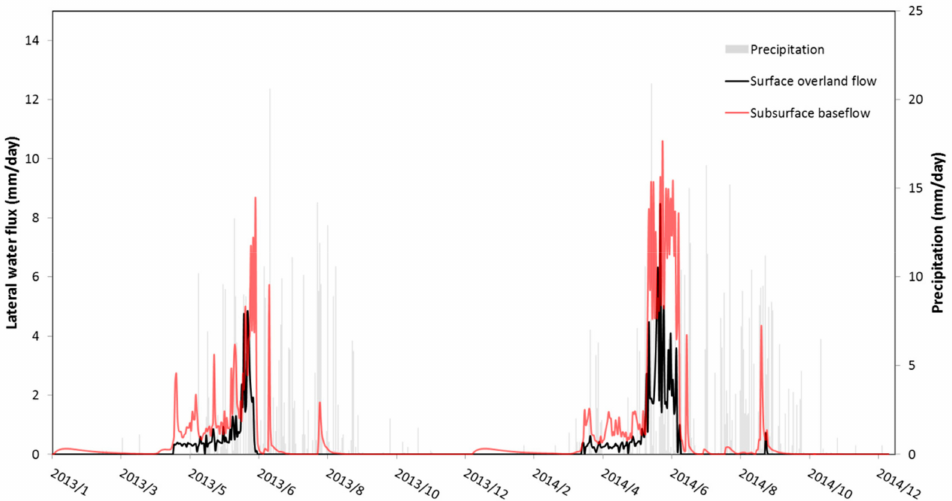
Figure 5. Temporal dynamics of simulated subsurface baseflow (SSB) and surface overland flow (SOLF) and precipitation in 2013 and 2014 at Arou